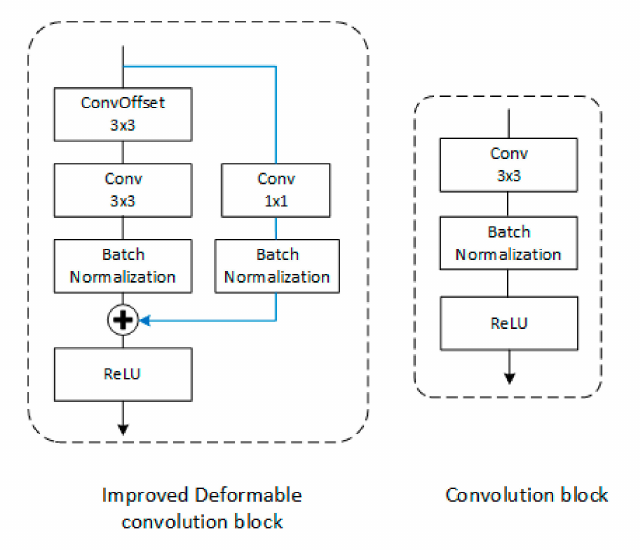
Figure 6. Detailed design of ordinary convolution block and improved deformable convolution